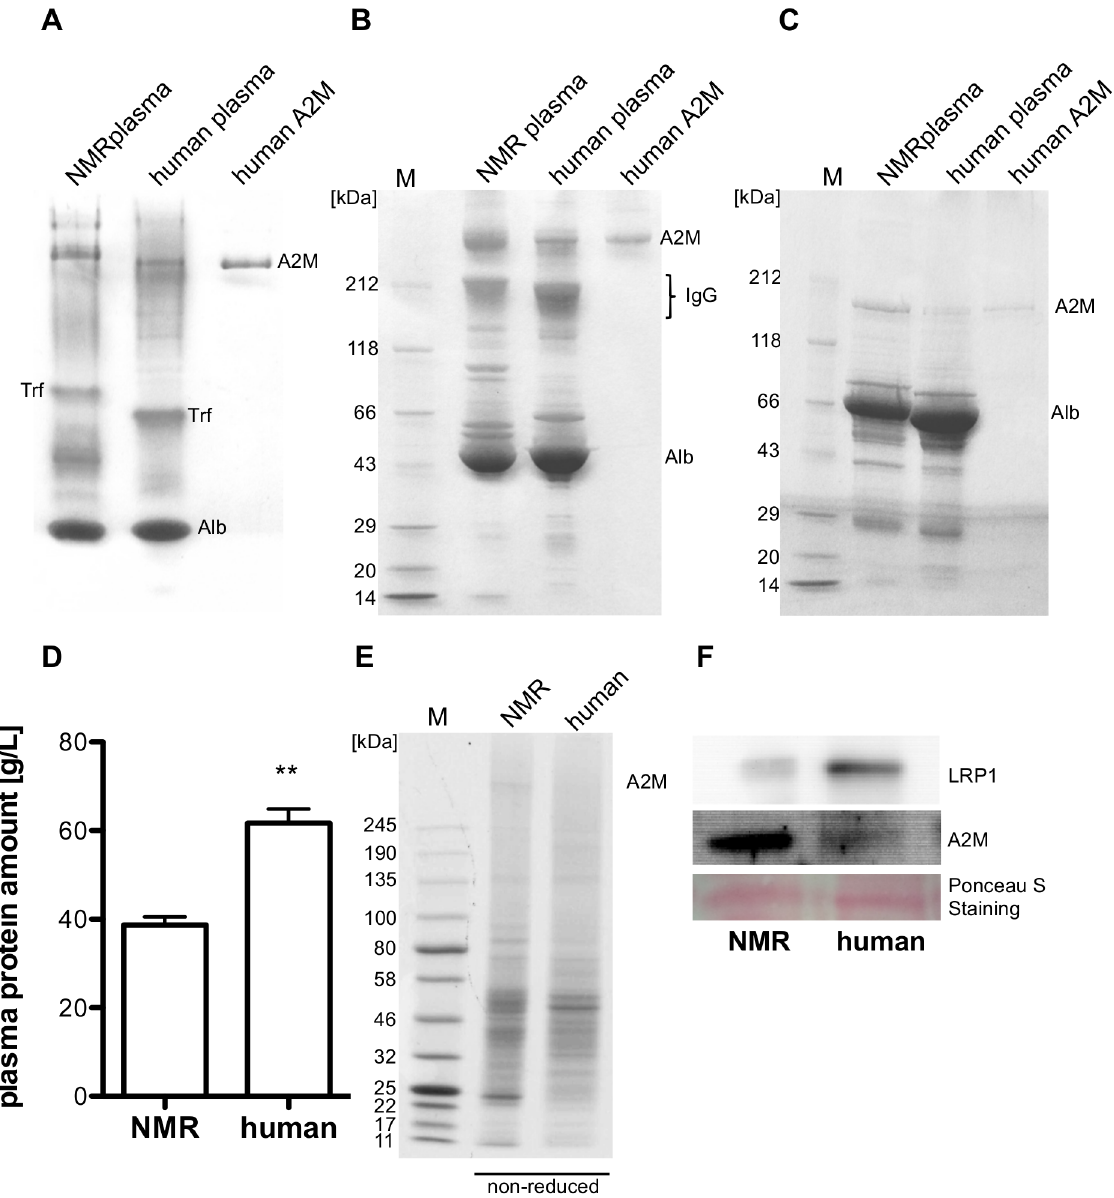
Fig 2. Plasma and liver protein analysis. NMR, human plasma (30 μ g) and purified human A2M (2.5 μ g) were separated by native PAGE (4 – 20%) (A) and SDS-PAGE (4 – 20%) under non-reducing (B) and reducing conditions (C). The protein concentration of NMR and human plasma was determined according to Bradford ( ** — p < 0.01) (D). Protein extracts from human and NMR liver (20 μ g each) were separated by SDS-PAGE (4 – 20%) (E) and subjected to western blot analysis using a polyclonal rabbit anti-human A2M antibody (5 μ g/mL) and a monoclonal mouse ß-subunit specific anti-human LRP1 antibody (10 μ